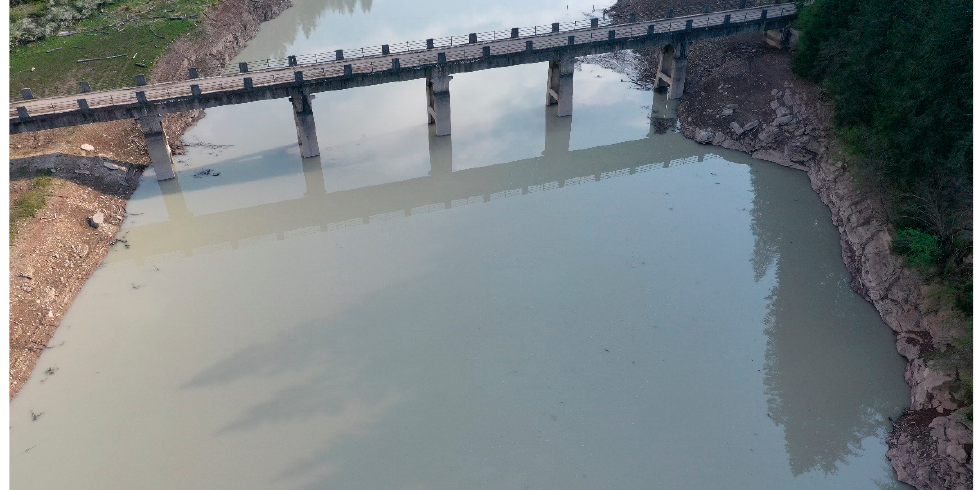
Figure 8. Specular reflection of bank vegetation and the bridge on the flat